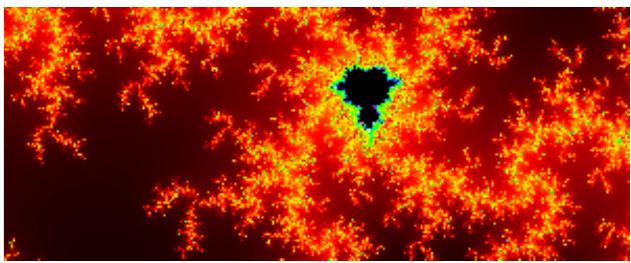
Figure 7. Mandelbrot image generated with XMin equal to 0.2035629459272944, XMax equal to 0.20243564914073117, YMin equal to 0.81859534365893782, YMax equal to 0.81814009408410127, a Width of 300, a Height of 121, and a limit of 678 iterations.